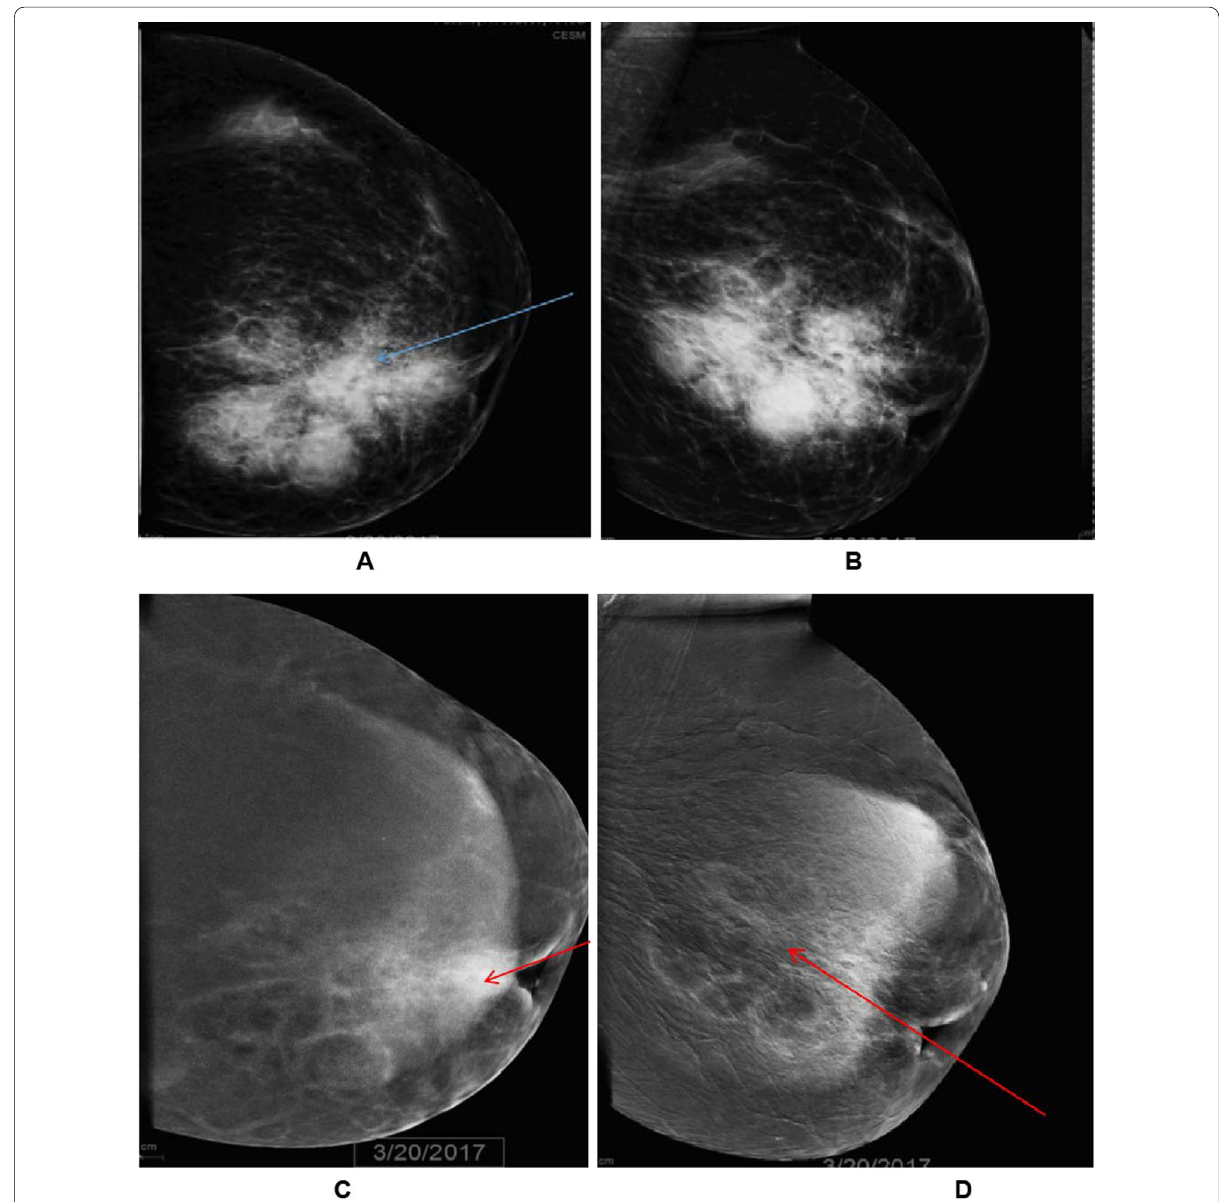
architectural distortion encroaching LIQ (blue arrow). c , d CEDM: c CC and d MLO views of the left breast showed moderate multiple clustered ring enhancing lesions at the retro-areolar region with parenchymal enhancement (red arrows). Pathological diagnosis: Periductal